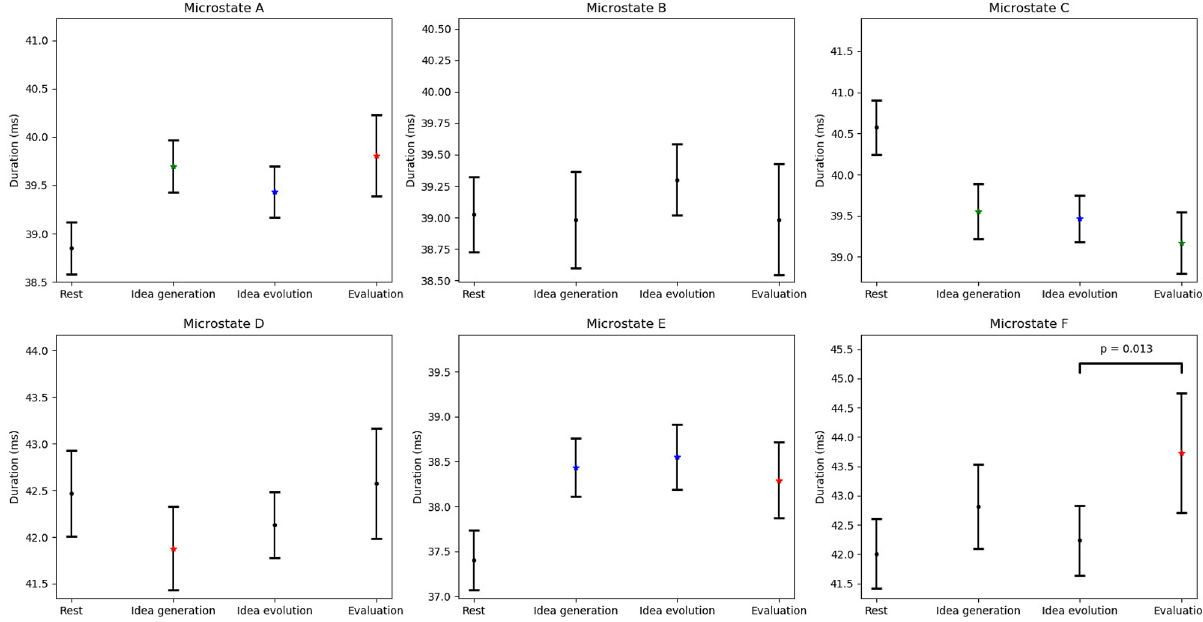
Figure 6. Error bar of microstate duration for rest, idea generation, idea evolution, evaluation, and differences between the conditions. P-values are represented by the black dots ( p > 0.05 ), red asterisks ( p < 0.05 ), green asterisks ( p < 0.01 ), and blue asterisks( p < 0.005 ) between rest and the three modes thinking. P-values are annotated between idea generation, idea evolution, and